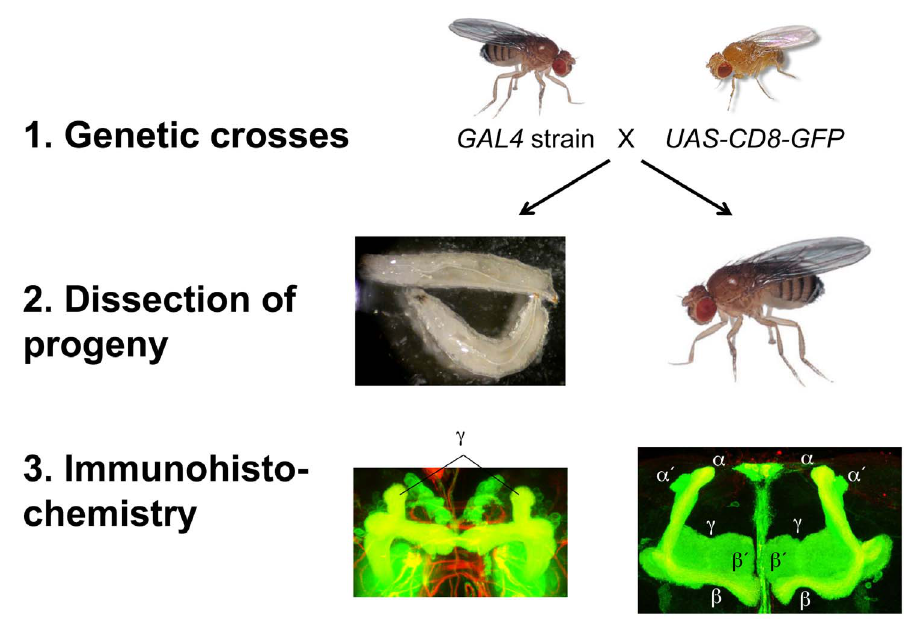
Fig. 4. Characterization of GAL4 expression patterns. Flies from a GAL4 strain of interest are crossed to flies carrying the reporter gene UAS- CD8-GFP . Animals are dissected at the wandering third instar larval stage or as adults. Whole nervous systems are fixed, stained, mounted, and imaged. In larvae, c neurons bifurcate to innervate both dorsal and medial lobes. In adults, c neurons innervate a broad medial lobe, the a 9 / b 9 neurons bifurcate to innervate FasII-negative dorsal and medial lobes, and the a / b neurons bifurcate to innervate FasII-positive dorsal and medial lobes. Green: anti-CD8. Red: anti-FasII.